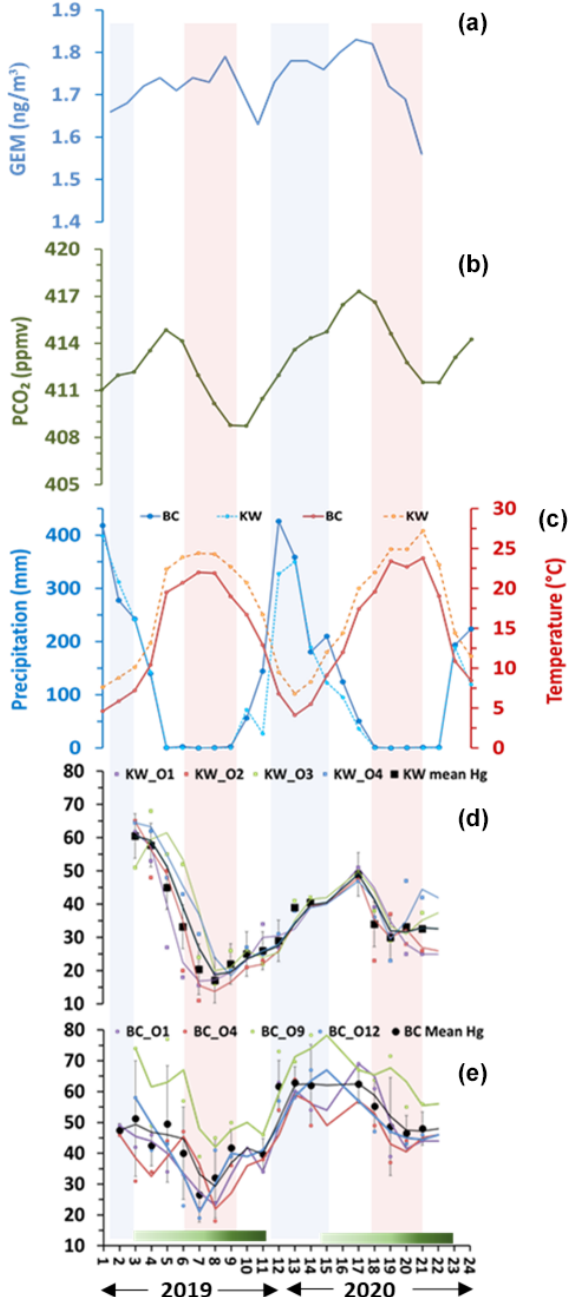
Figure 3. Seasonal variations of (a) atmospheric Hg(0) (Martino et al., 2022), (b) pCO 2 (NOAA Global Monitoring Laboratory), (c) precipitation and temperature of Bchaaleh and Kawkaba respec- tively, and (d) and (e) foliage Hg concentration in Bchaaleh and Kawkaba olive groves respectively. Shaded green horizontal bars represent the leaf development of olive trees during the growing season of cultivars in Spain according to the BBCH scale (Sanz- Cortès et al., 2002). Shaded colored lines correspond to the winter (blue) and summer